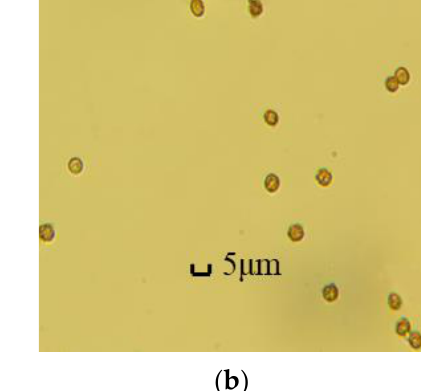
Table 1. Statistical results of spore enrichment experiments. Spore Type Average Number of Spores Enriched